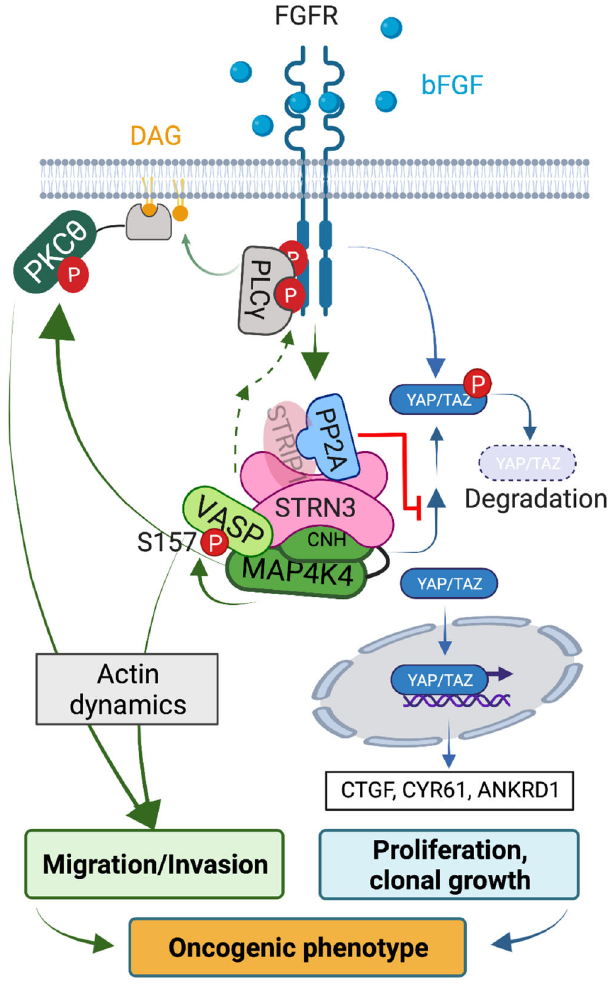
Fig. 7 Proposed model of MAP4K4 and STRN3 regulation of cell migration and proliferation in MB. MAP4K4 is activated downstream of RTK signaling and exerts both pro-invasive and anti-proliferative activities in MB cells. Invasion regulation: STRN3 cooperates with MAP4K4 to control cell migration, invasion, and actin cytoskeleton remodeling, independently from PP2A activity. This cooperation of MAP4K4 and STRN3 is necessary for the FGFR-induced activation of motility-associated effectors nPKCs and VASP. Proliferation regulation: MAP4K4 causes LATS1/2 phosphorylation, which promotes the activation of the Hippo pathway. Hippo pathway activation results in the phosphorylation and degradation of the transcriptional regulator YAP. The consequent repression of YAP transcriptional activity leads to a proliferation arrest. STRN3 promotes PP2A-mediated inactivation of MAP4K4 function toward Hippo activation, resulting in an increase of YAP transcriptional activity and cell